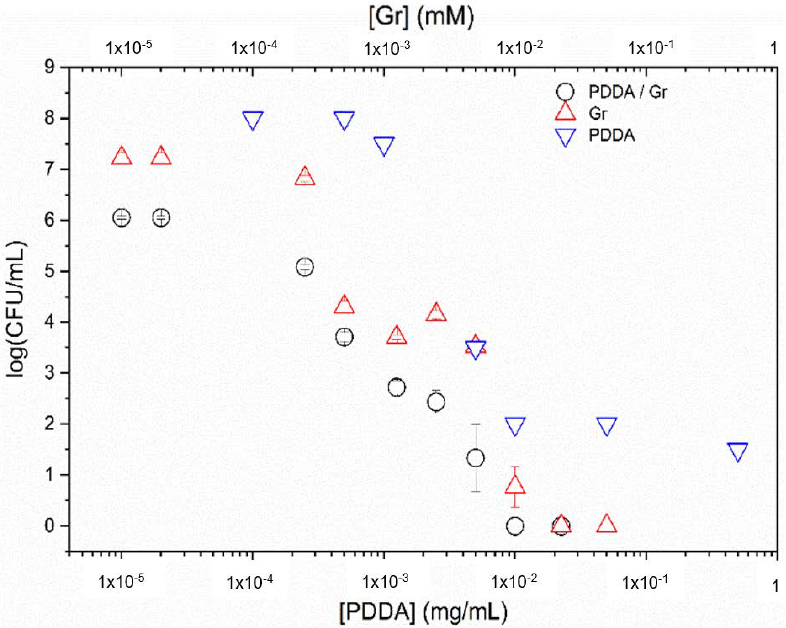
Figure 8. Cell viability of Staphylococcus aureus (10 6 –10 8 CFU/mL) after interacting for 1 h with gramicidin nanoparticles (Gr NPs), poly (diallyldimethyl ammonium chloride) PDDA/Gr NPs, or PDDA solutions over a range of Gr and/or PDDA concentrations. Data for cell viability over a range of [PDDA] were taken from [22]. Gr NPs only (red triangles) showed MMC equal to double the MMC obtained for the Gr NPs/PDDA dispersion (black hollow circles). PDDA only (inverted blue triangles) did not cause a complete loss of S. aureus via- bility, as reproduced from [22]. Against S. aureus , Gr NPs/PDDA dispersion yielded the lowest MMC values for Gr. This was half the dose for the Gr NPs: MMC = 0.02 mM (Figure 8). Given Gr toxicity, Gr dose reduction in the combination with PDDA might be a significant advantage. In Figure 9, Gr NPs, PDDA, and Gr NPs/PDDA dispersions were tested against Candida albicans . There was a reduction in Gr and PDDA MMC required for the complete loss of fungus viability for the Gr NPs/PDDA combination, with 0.5 μg·mL − 1 of each an- timicrobial agent, comparing favorably with the required dose of 2.5 μg·mL − 1 of Gr NPs to reduce fungus viability to zero or with PDDA only that was unable to completely kill at 500 μg·mL − 1 (Figure 9). Testing covalently bound Gr in gold coatings yielded only a 90% reduction in fungus viability [42].